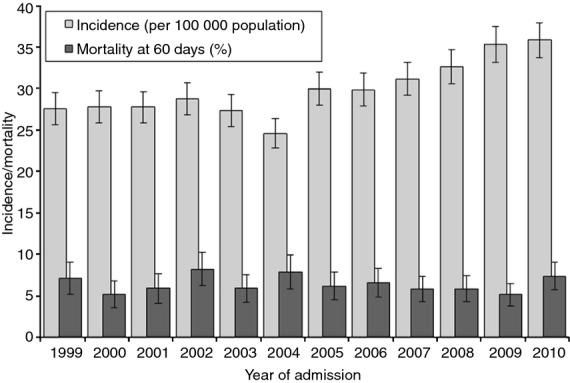
Trends in incidence (per 100 000 population) and mortality (at 60 days) following admission for acute pancreatitis, in Wales from 1999 to 2010. Incidence and mortality are standardised for age group and gender. Vertical bars represent 95% confidence intervals.